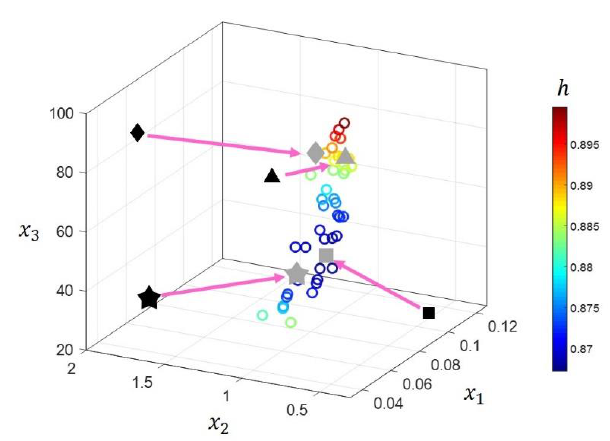
Figure 5. Local minima of the vibration intensity function.